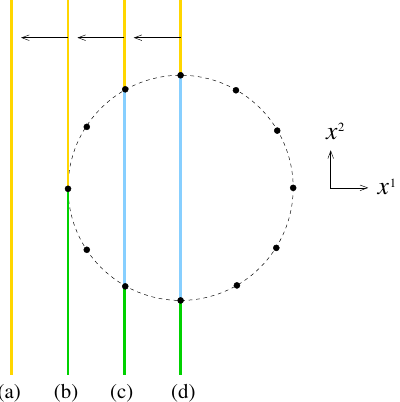
Figure 10. A sequence of D1-branes probing the circular array of NS5-branes, varying the dis- placement x 1 = b of branes lying in the x 1 - x 2 plane. The NS5’s fractionate the D1 probe into segments indicated in yellow, blue, and green.